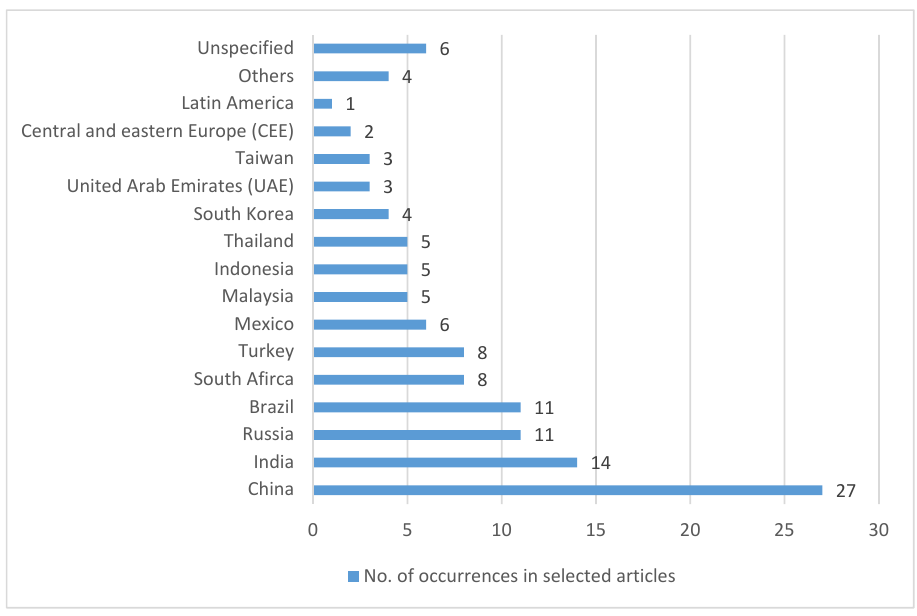
Figure 4. Numbers of occurrences of emerging economies in selected articles.